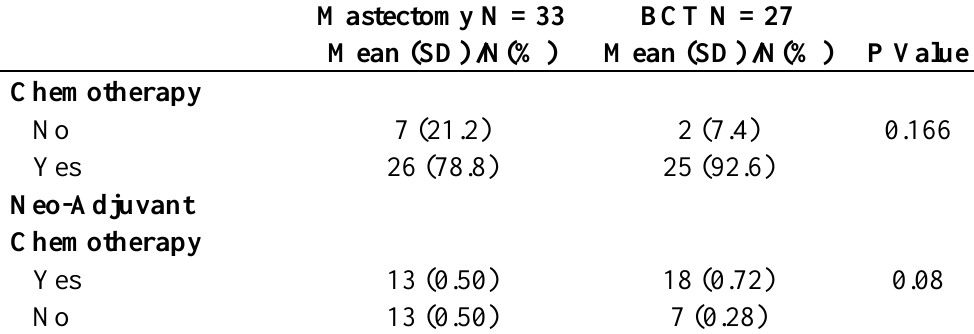
Table 3. Treatment, Pathology, Status, and Staging by Treatment